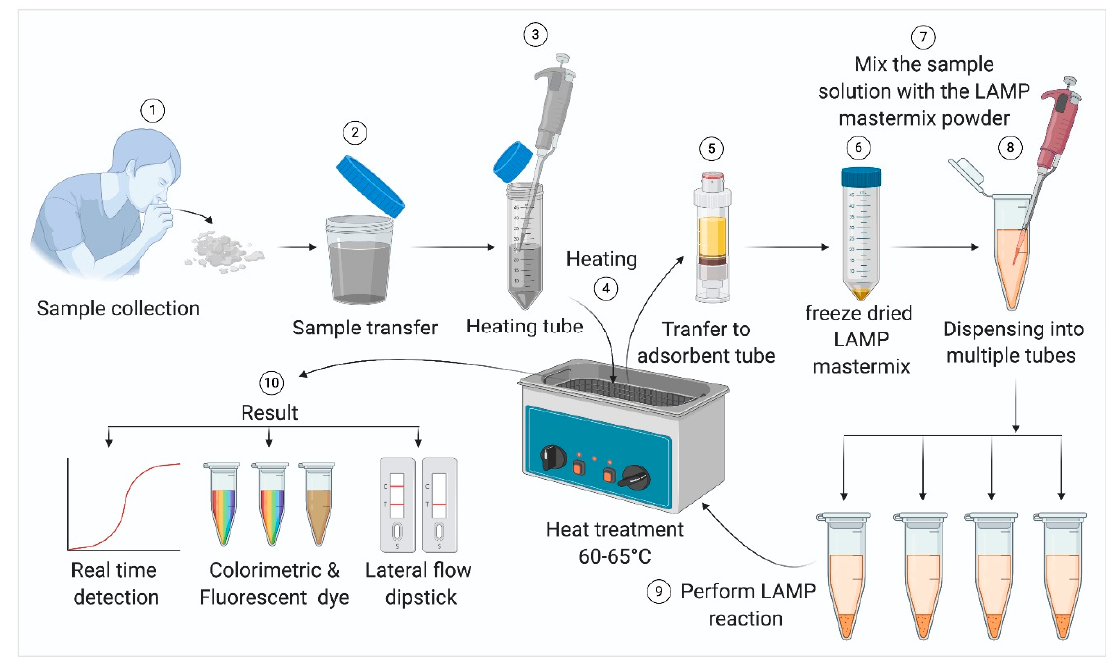
Figure 3. Steps in sample processing for the LAMP reaction, the LAMP reaction in a simple water bath, and the detection of amplicons.